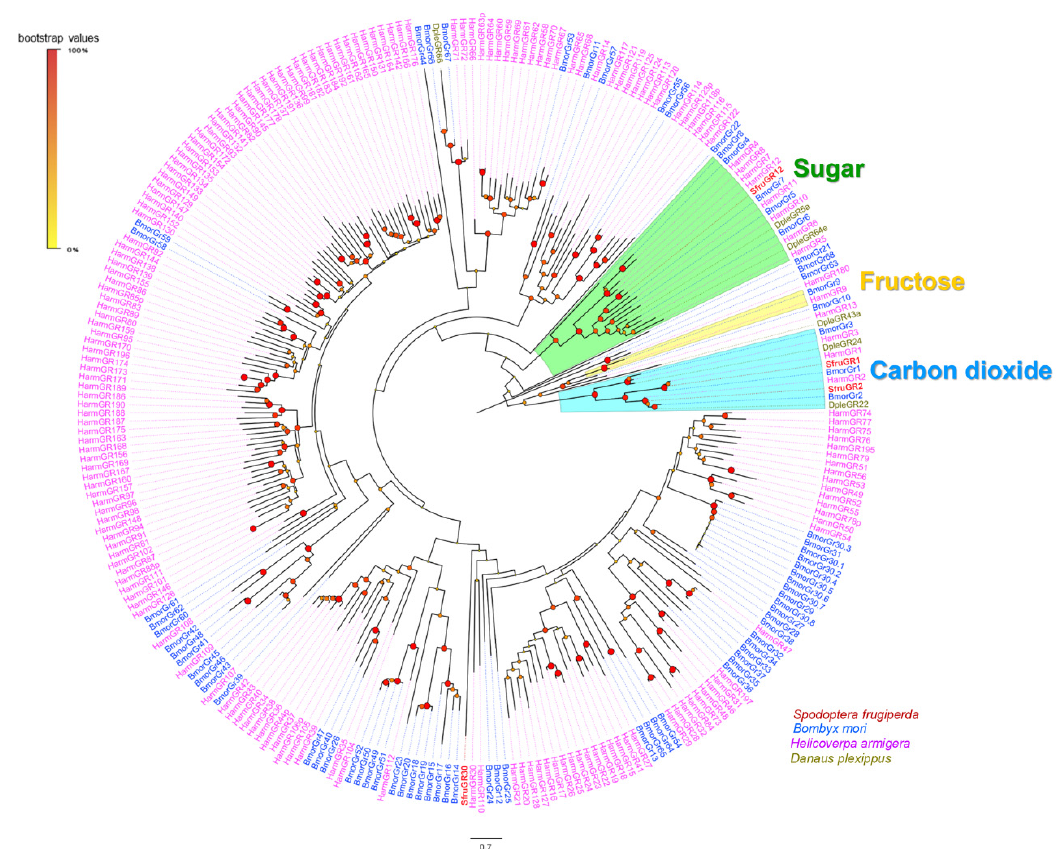
Figure 4. Phylogenetic relationships of GRs from S. frugiperda and other lepidopteran species. The neighbor-joining tree was constructed using MEGA7 based on candidate GRs from S. frugiperda (Sfru), H. armigera (Harm), B. mori (Bmor), and Danaus plexippus (Dple). Branches of the putative carbon dioxide receptors are highlighted in blue; branches of putative fructose receptors are highlighted in yellow; branches containing “sugar-taste receptors” are highlighted in green; and branches containing “bitted-taste receptors” are not highlighted.